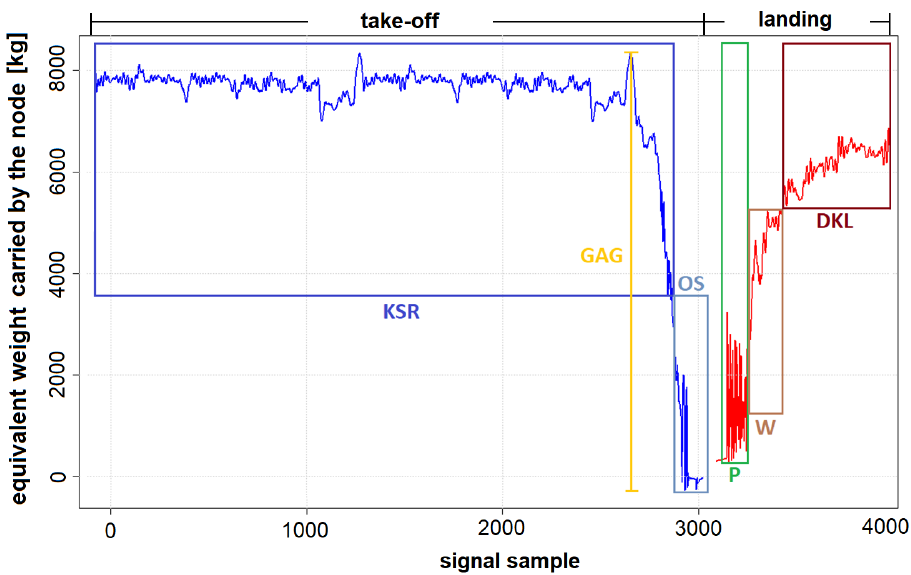
Figure 13. An example of strain record for full stop landing with indication of subsequent stages of this